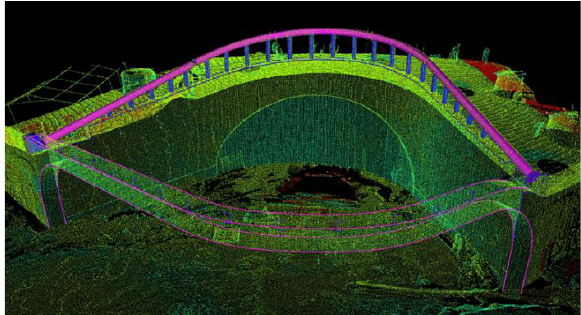
Figure 3 . 3D point cloud of the bridge structure with design objects.